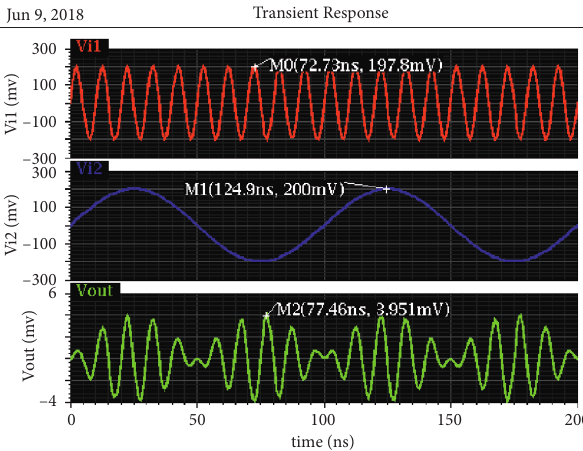
Figure 6: The transient response of the analog multiplier.